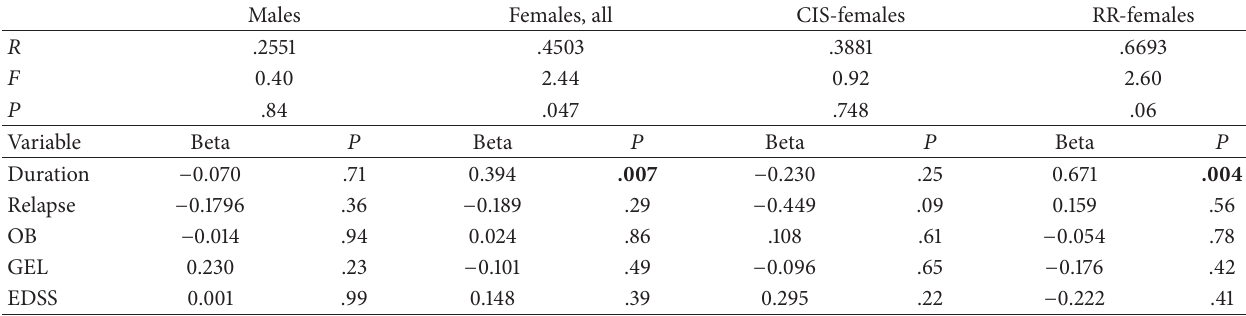
Table3:Multipleregressionanalyseswithdependentvariableratioleptin/BMI,anindexofadipocyteleptinsecretingactivityintherapy-na¨ıve male and female MS patients. CIS: clinically isolated syndrome; RR: relapsing-remitting MS; duration of illness in months; OB: oligoclonal bands in CSF; GEL: gadolinium enhanced lesions in MRI; EDSS: score in the expanded disability status scale.